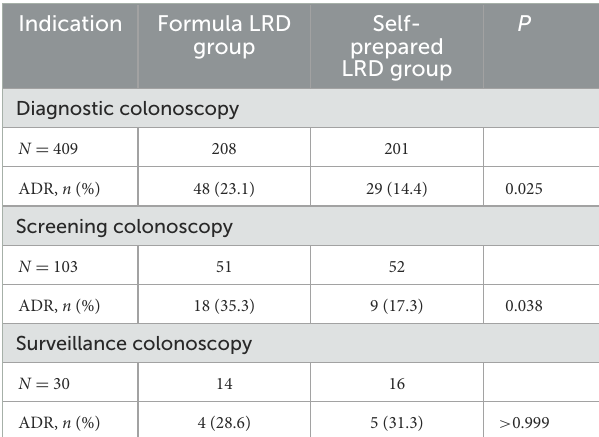
TABLE 6 Subgroup analysis of adenoma detection rate for different